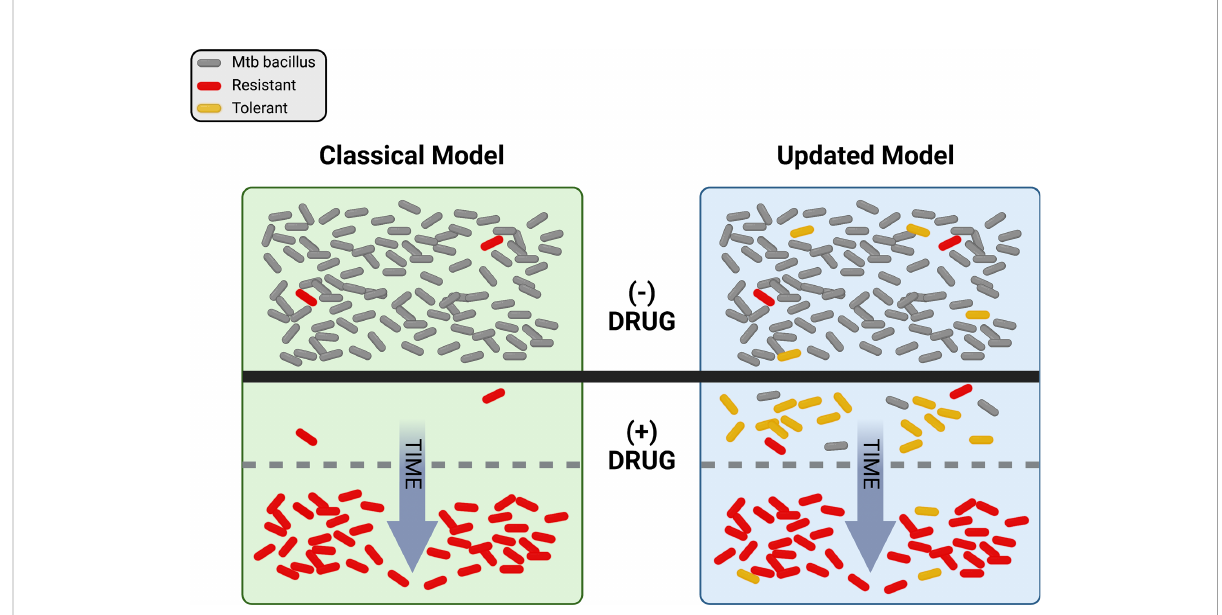
FIGURE 1 Visual representation of the classical and updated models for development of antibiotic resistance in Mtb. The top portion shows a population of Mtb in the absence of drug selection (- DRUG). In the classical model, pre-existing resistant bacilli (red) in the population grow despite the addition of drug (+ DRUG) and susceptible bacteria (gray) are eliminated over time until only resistant cells remain. In the updated model, pre-existing resistance may still be present, but tolerant bacilli (yellow) may also be present and/or be induced by drug exposure. With drug selection, susceptible bacteria are again eventually eliminated, with resistance dominating the population over time. Figure created with